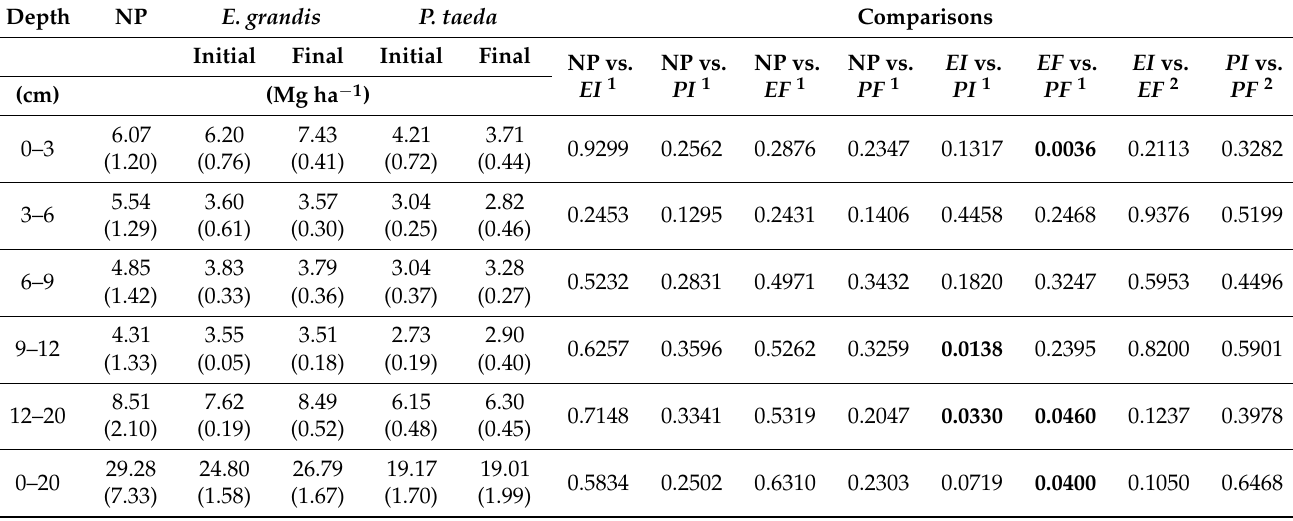
Table 9. SOC stock under P. taeda , E. grandis and native pastures at the beginning and end of the study. Depth